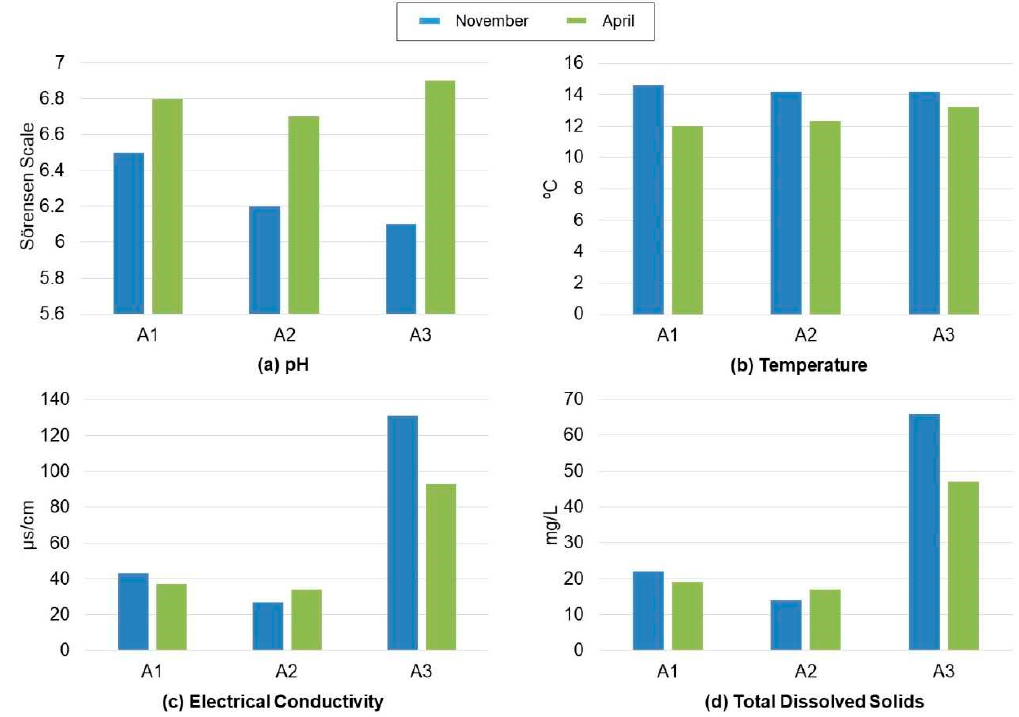
Figure 5. Water seasonal variation from the Cávado River. Water samples reference the same as in Figure 3.